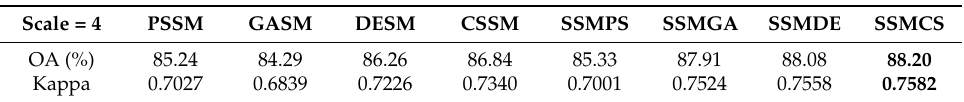
Table 4. Comparison of the land-cover change detection performances of the sub-pixel mapping algorithms in Experiment 2 (change/no change).